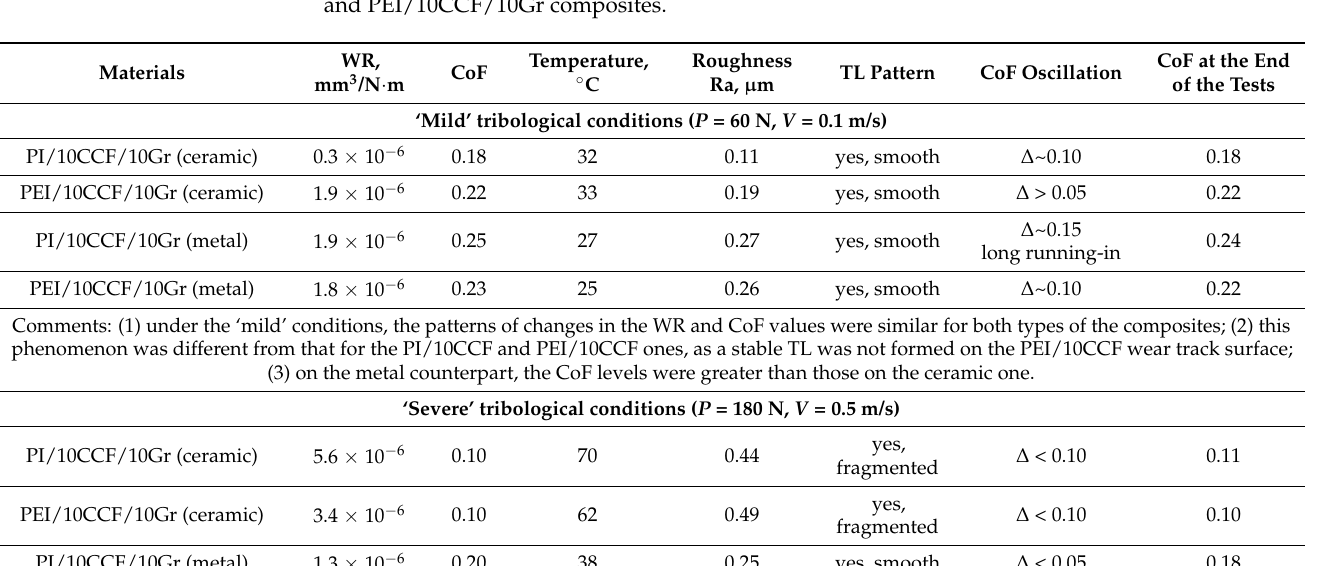
Table 7. A comparison of the tribological properties and the TL characters for the PI/10CCF/10Gr and PEI/10CCF/10Gr